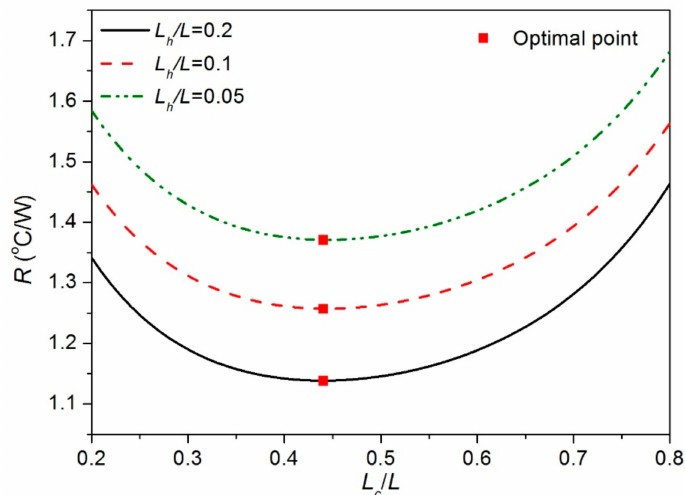
Figure 11. Thermal resistances for various heated lengths ( Q = 0.2 m 3 / min, w c = 7